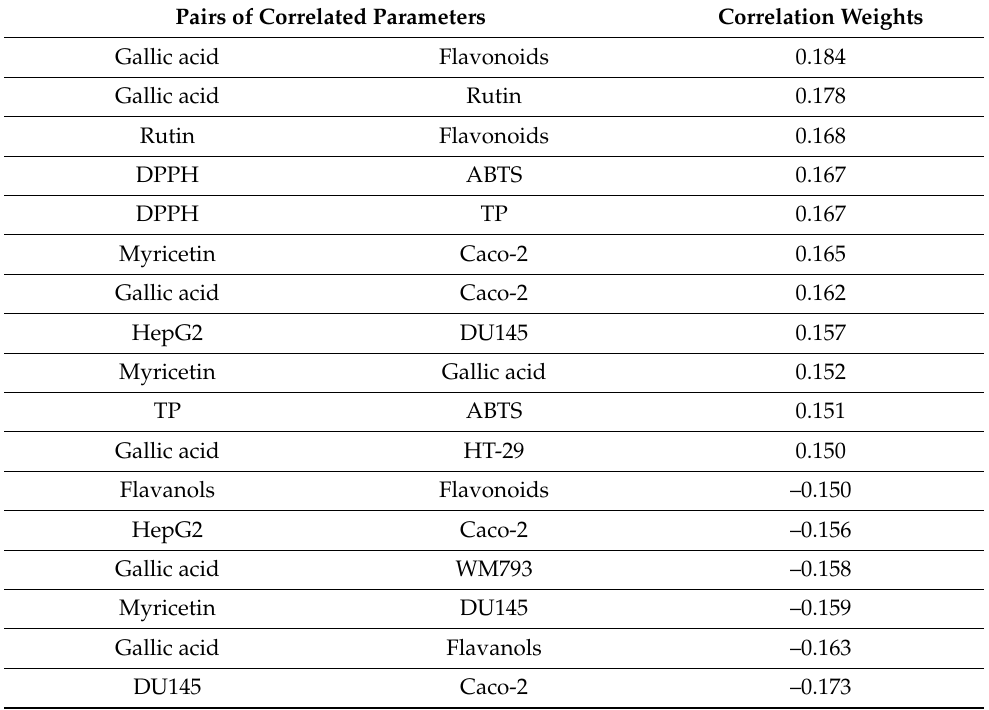
Table 3. Correlation weights for the pairs of parameters based on PLS model (only correlation weights with absolute values higher than 0.149 were shown). Pairs of Correlated Parameters Correlation